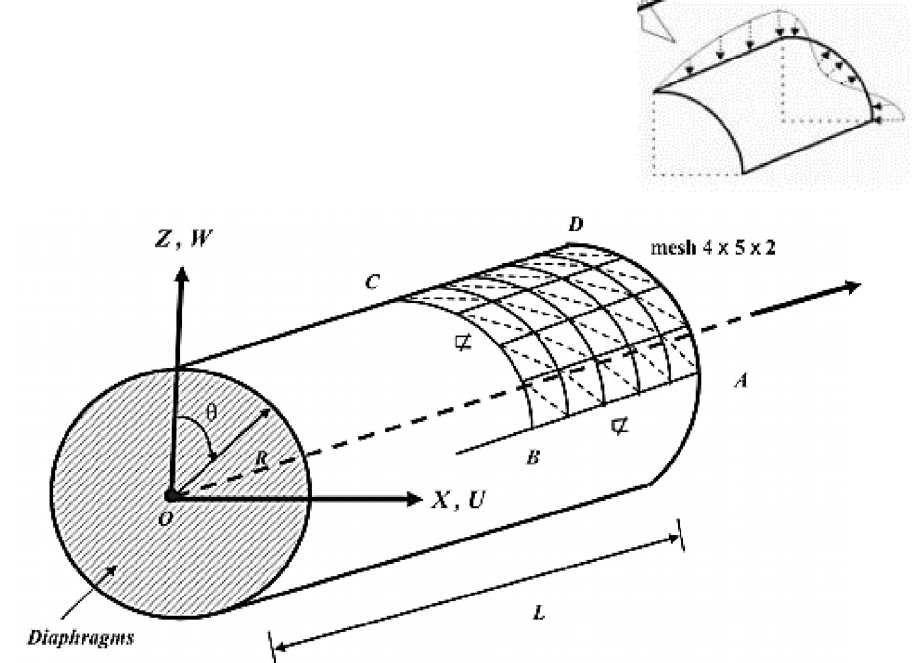
Fig 11. Cylindrical crossed multi-layer shell simply